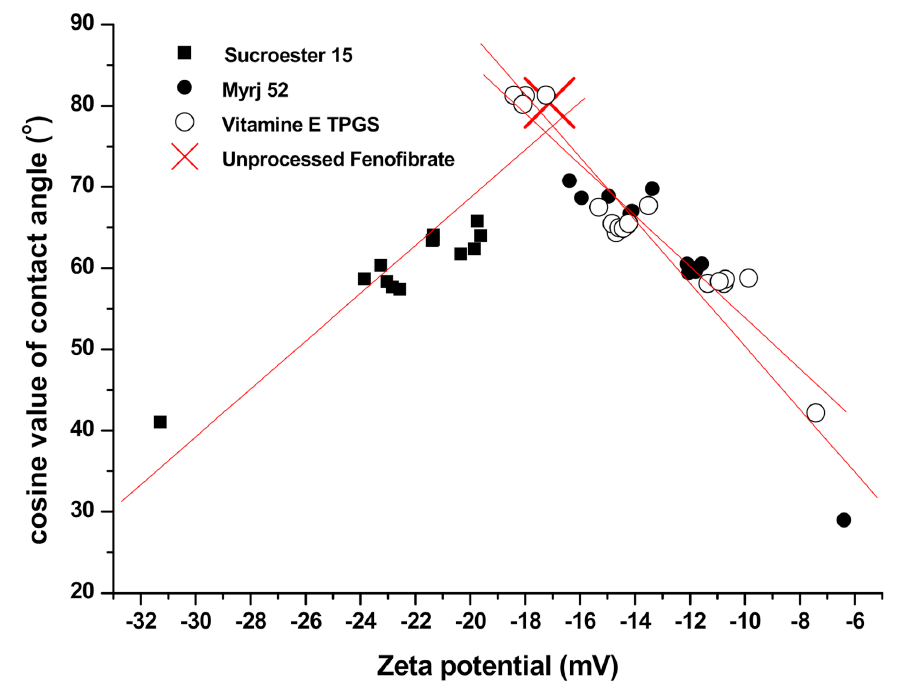
Figure 5. The relationship between zeta potential values and equilibrium contact angles.